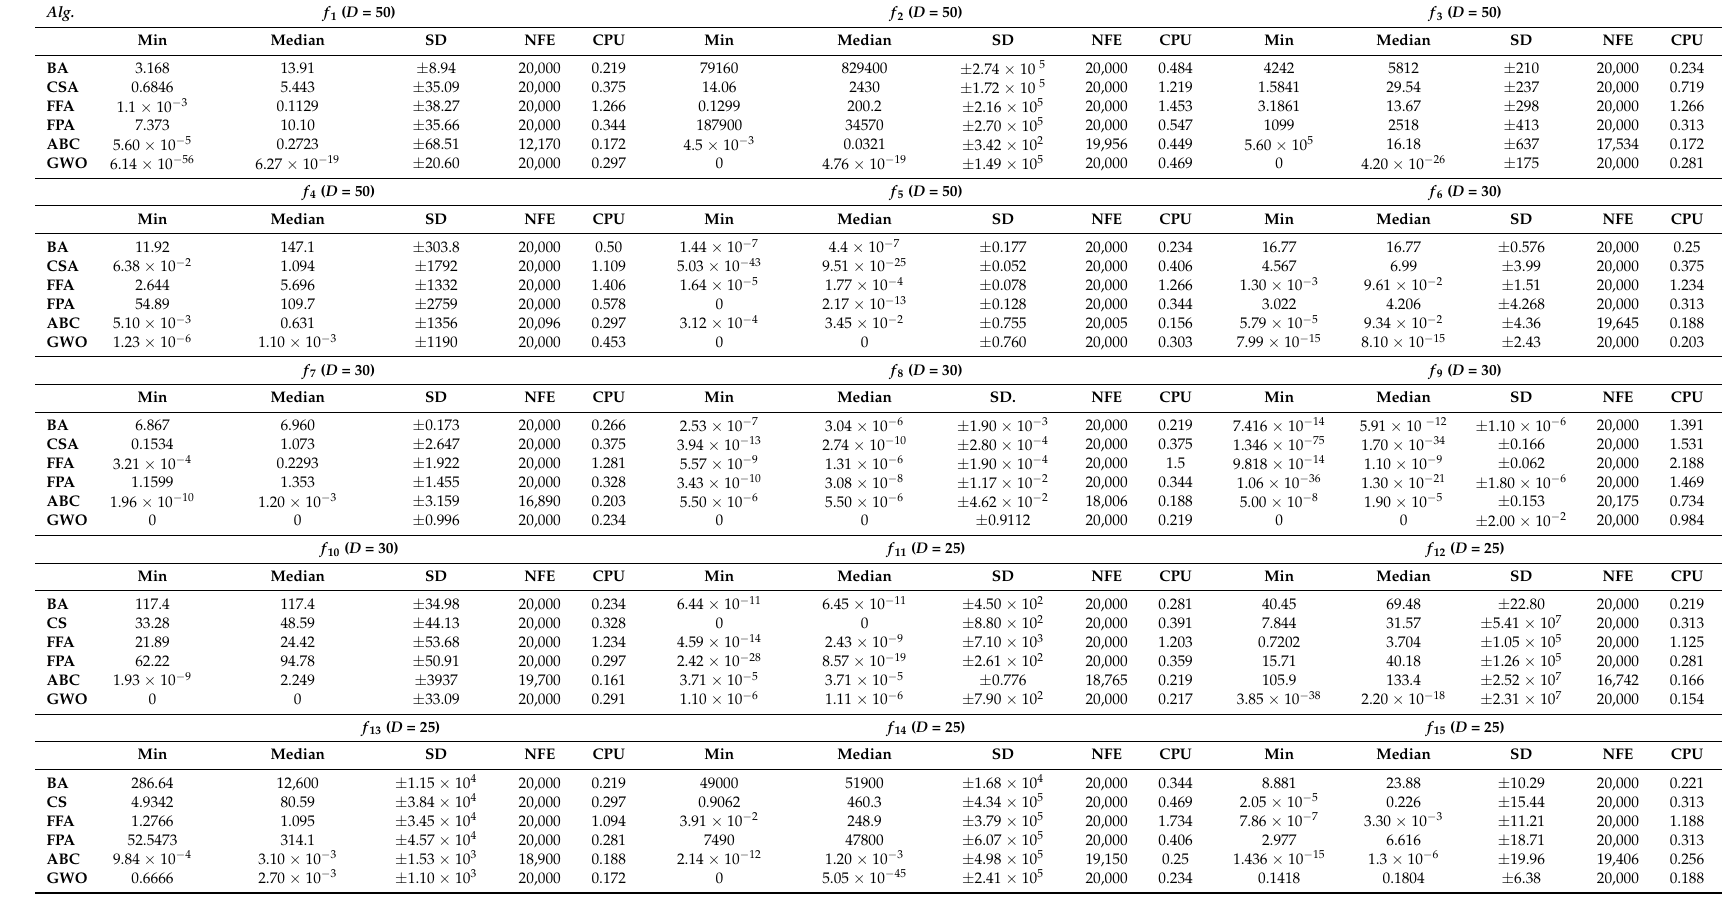
Table 4. This table is a summary of results for unconstrained optimization